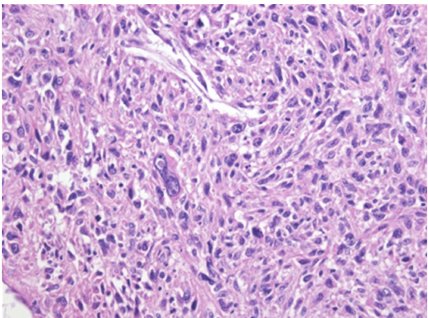
Figure 4: Microscopic view (400x) of the tumor located in a lymph node, diagnosed to be a localization of a high grade sarcoma